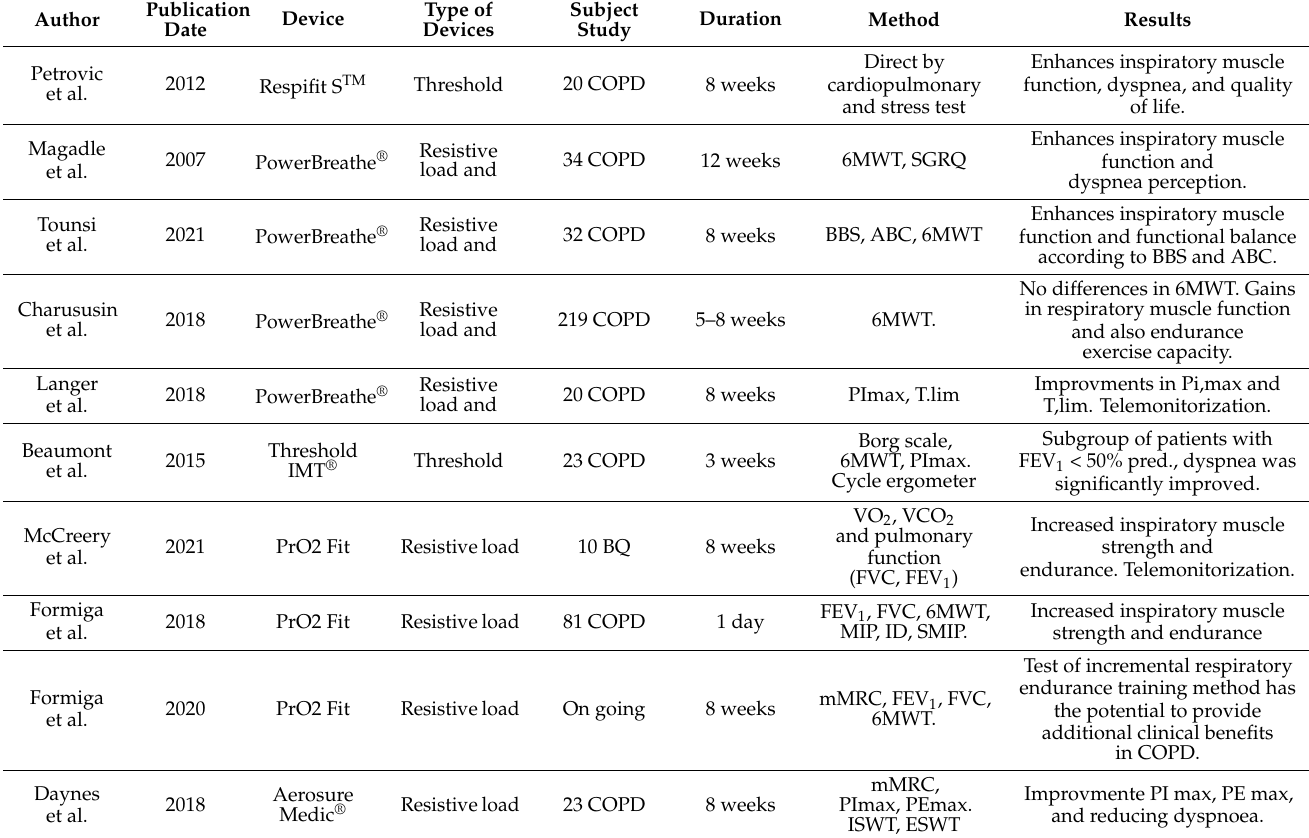
Table 1. Bibliography search of IMT devices.